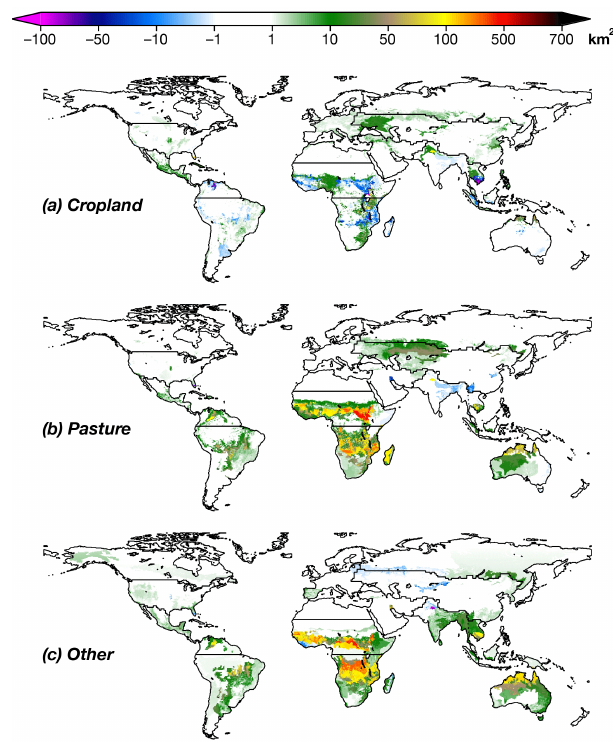
Figure 4. Maps of mean annual burned area (km 2 ) associated with (a) cropland, (b) pasture, and (c) other land. These are calculated from monthly maps generated by the equation B i = c F k A k,i for each month and region. The results can be interpreted as how much more (or less) fire would be expected if the area of the given land cover were to double (and the others remain the same). Corresponds to Fig. S5. Compare with seasonal maps in Figs. S8–S11.